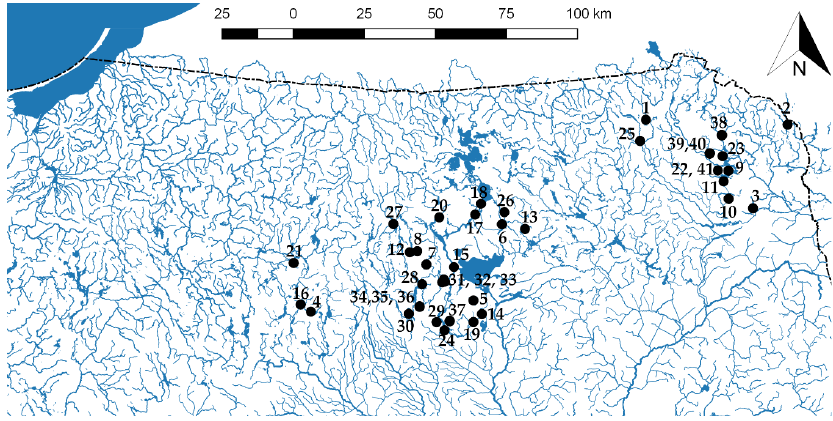
Figure 1. Localization of the studied lakes in NE Poland. The names of the lakes and characteristics are in Table 1. Table 1. Morphometric and trophic characteristics of the lakes. SDV—Secchi disc visibility; meta depth—depth range of the metalimnion; TSI—Carlson trophic state index; HDI—hydrochemical dystrophy index; oligo—oligotrophic; meso—mesotrophic; eu—eutrophic; dy—dystrophic; nd.—no data. The number of lakes corresponds to the map in Figure 1. For the oxygen group characteristics, see the Method section and Figure 2.